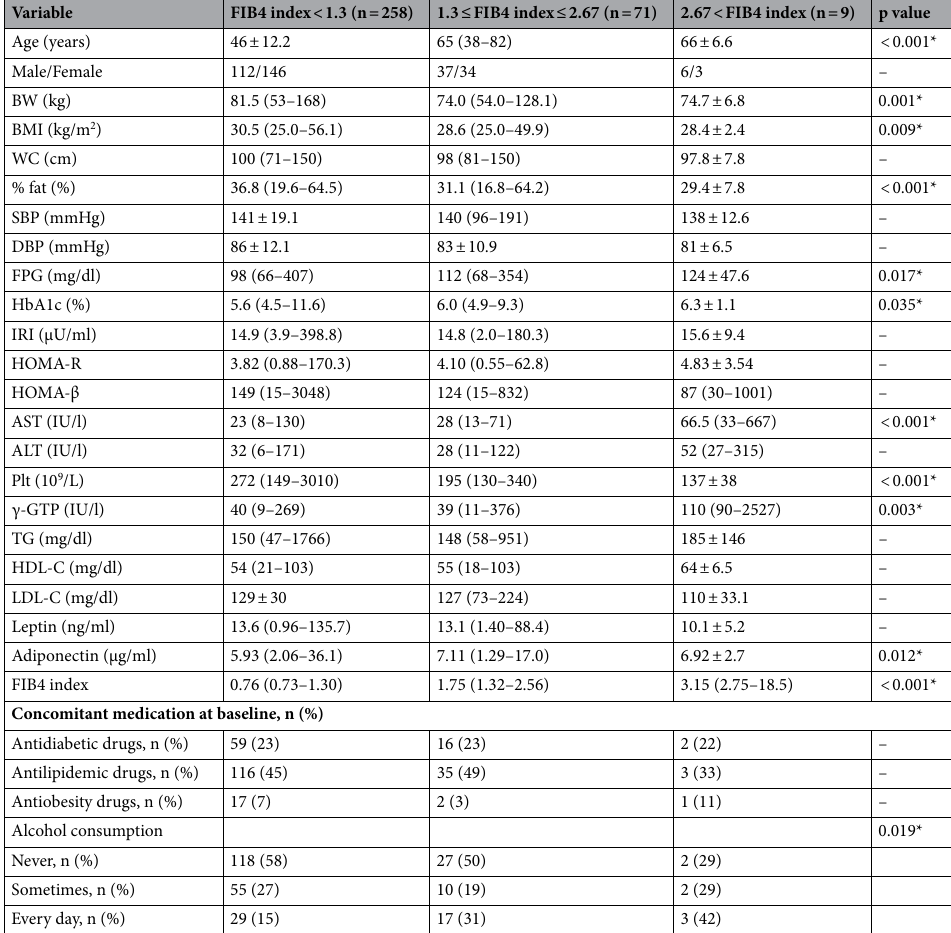
Table 5. Baseline characteristics of patients categorized by the FIB4 index. Data are expressed as the mean ± SD, medians (min, max), or percentages. Asterisks indicate a significant difference (p <